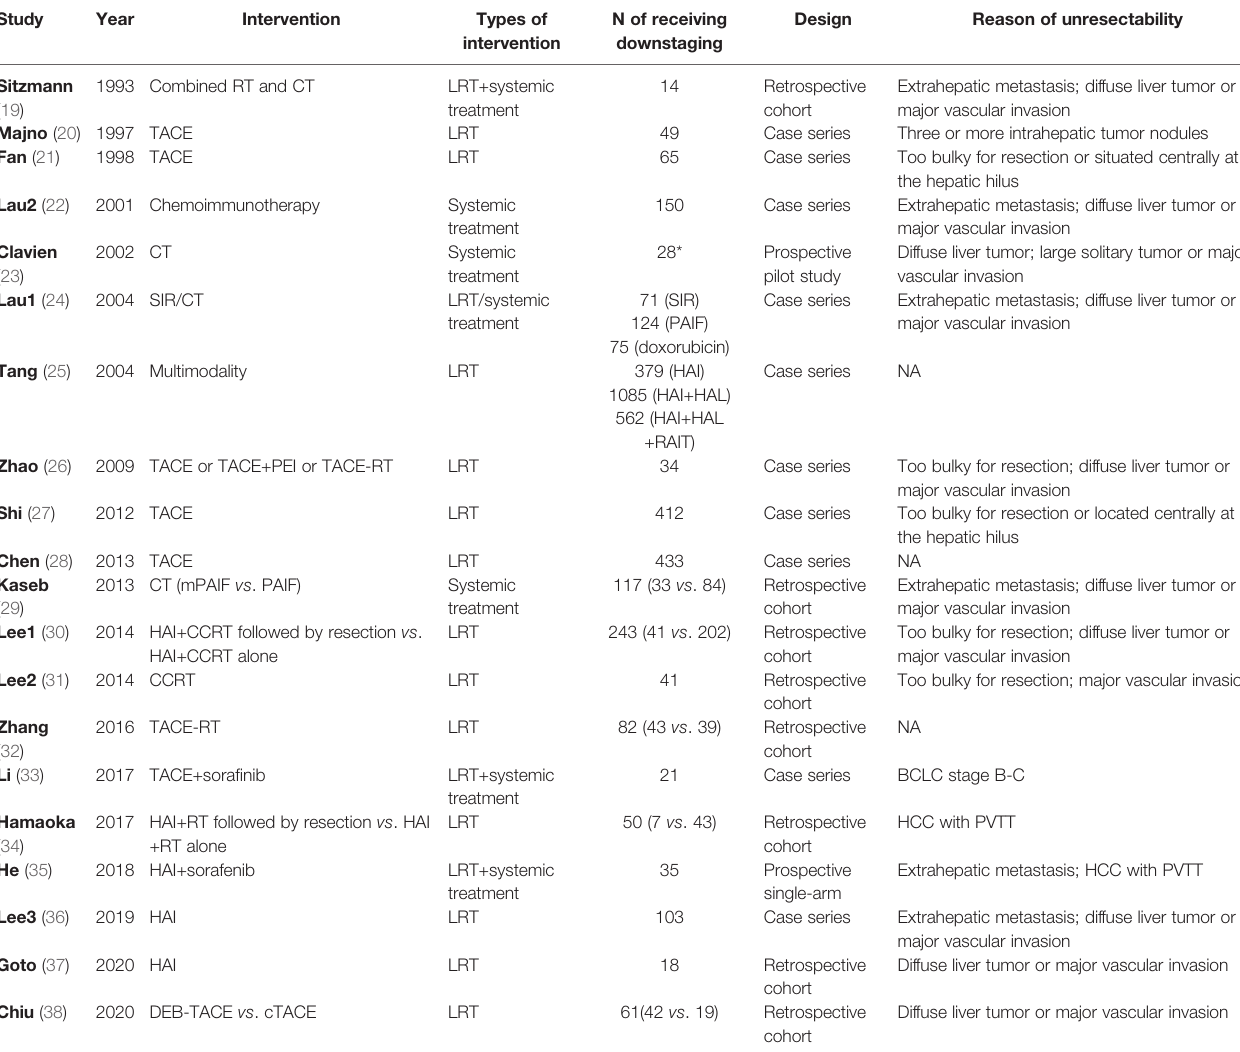
TABLE 1 | Studies of downstaging therapy for hepatic resection of HCC.